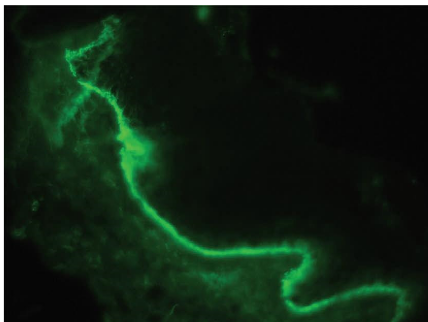
Figure 4: Skin biopsy. Lupus band: linear immune complexes deposition along dermo-epidermal junction (IF, C1q; ×